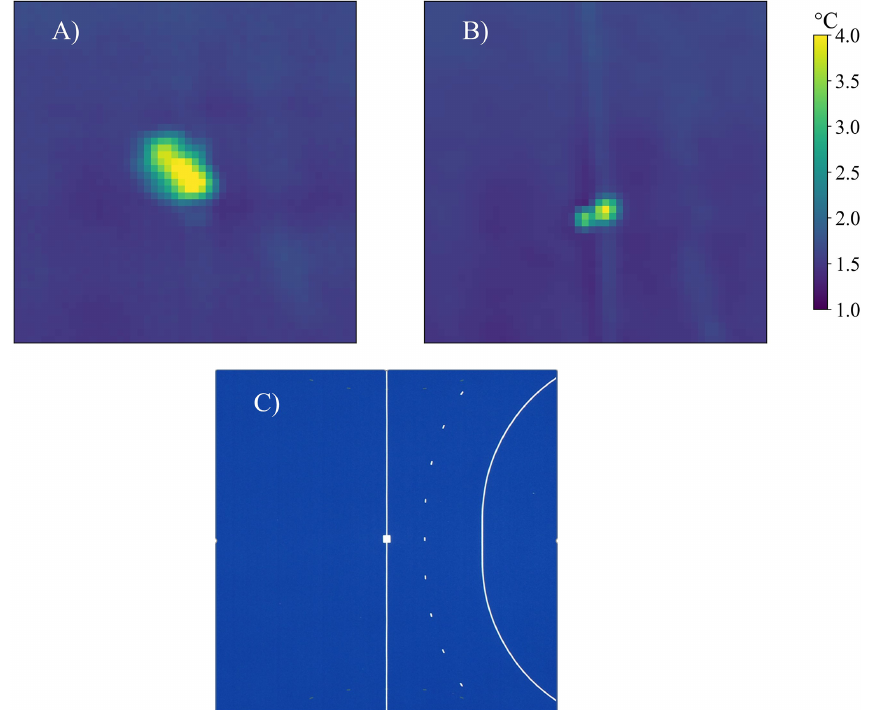
Figure 4. Standard deviation over time for (a) unstable and (b) stabilized thermal imagery – impact of stabilization algorithm on the bright- ness temperature ( T b ) standard deviation over time zoomed to a low-emissivity target of the TURF-T1 experiment. Panel (a) shows the unstable T b standard deviation, and panel (b) shows the stabilized T b standard deviation. Panel (c) shows RGB imagery with the blue turf and the low-emissivity target in the centre. The peaks of the standard deviation of panels (a) and (b) are shifted due to the working mechanism of the software stabilization. Any subsequent frame in the stabilization will be matched with the base frame (first frame), and the standard deviation peak is hence shifted towards this first